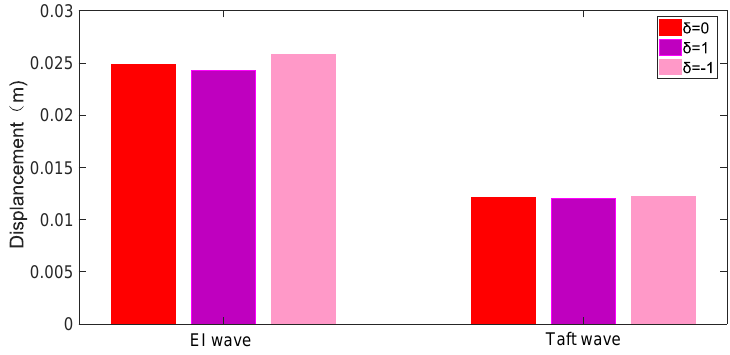
Figure 21. Maximum displacement from top floor of uncertain